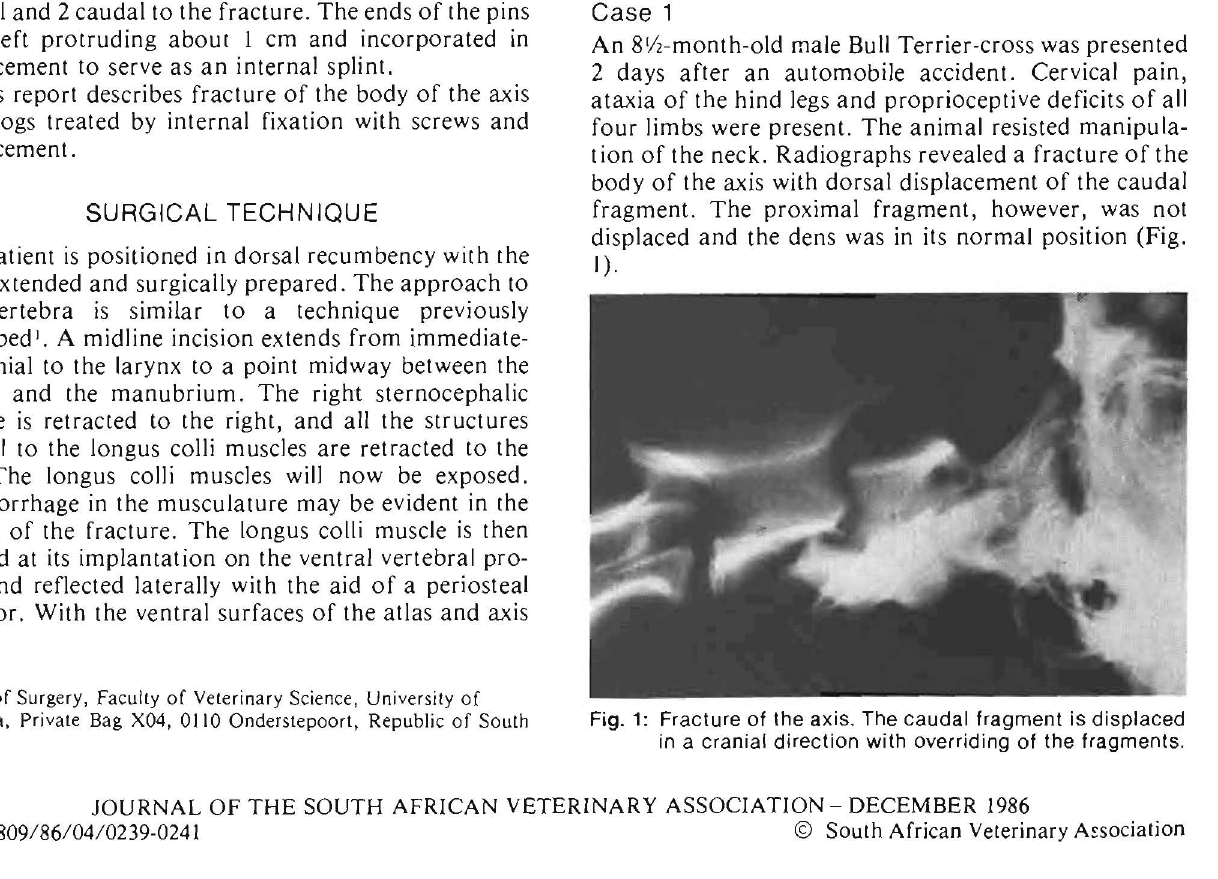
Fig. 1: Fracture of the axis. The caudal fragment is displaced in a cranial direction with overriding of the